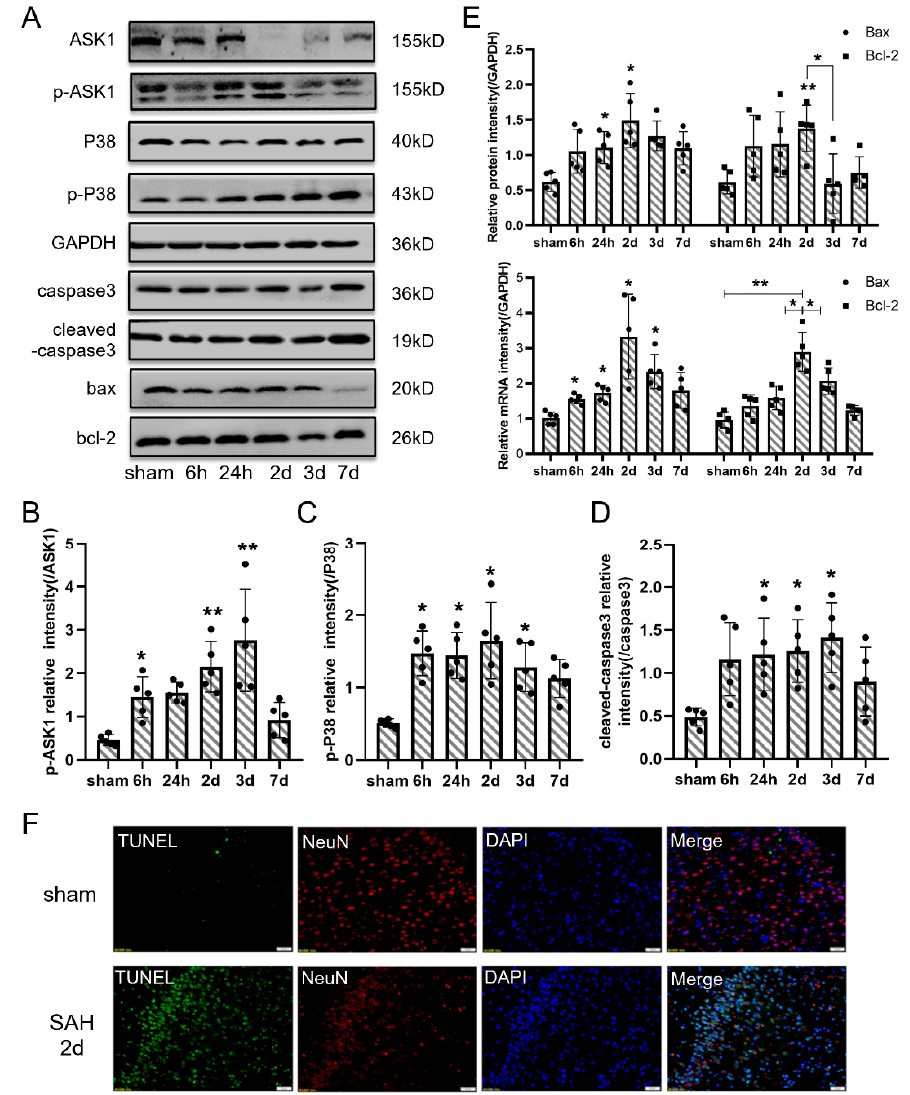
Figure 3. The apoptosis pathway was activated after SAH. ( A ) Representative bands of ASK1, p-ASK1, P38, p-P38, caspase3, cleaved-caspase3, Bax, and Bcl-2 expression in the cortex at each time point after SAH. ( B – D ) Quantitative analysis of Western blot results showed that the ratio of p-ASK1/ASK1, p-P38/P38 and cleaved-caspase3/caspase3 were significantly increased after SAH. ( E ) Quantitative analysis of Western blot and qPCR results showed that the protein and mRNA levels of Bax and Bcl-2 were increased after SAH. ( F ) Representative TUNEL staining in the cortex of right temporal lobe after SAH (TUNEL, green; NeuN, red; DAPI, blue). Bars represent the means ± SD. * p < 0.05; ** p < 0.01; vs. sham ( n = 5 in each group). Bar = 50 μ m.